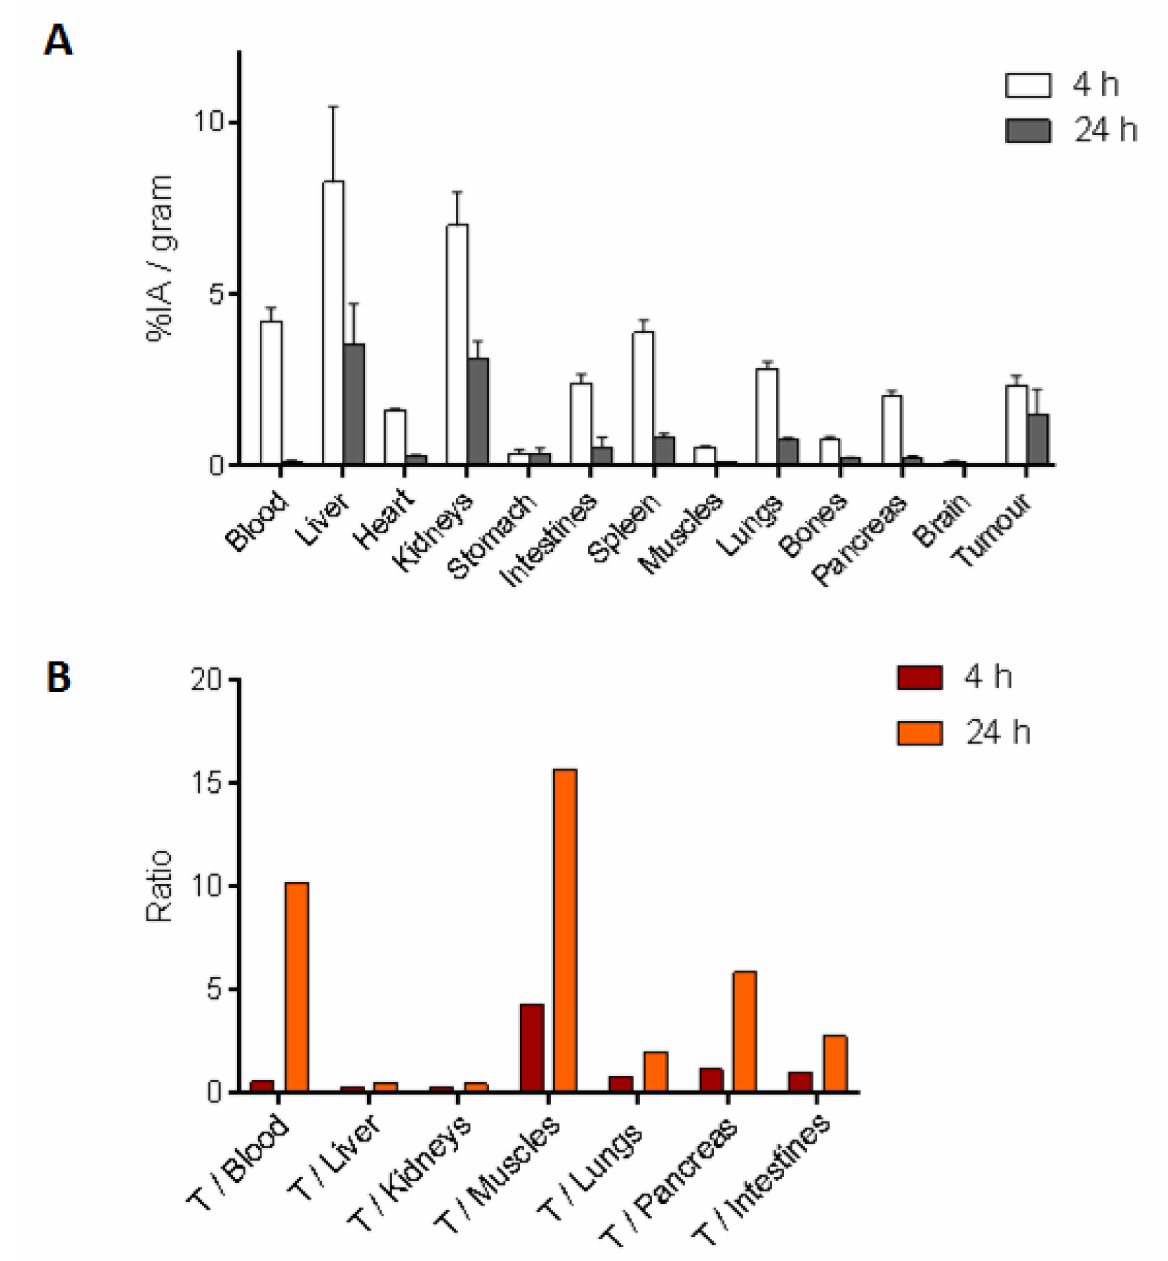
Figure 4. Biodistribution in multiple organs of [ 111 In]In-IP-001 in A549 cancer-bearing nude mice ( n = 3; mean ± SD) at 4 and 24 h post injection ( A ); ratios of the tumor uptake to major organs ( B